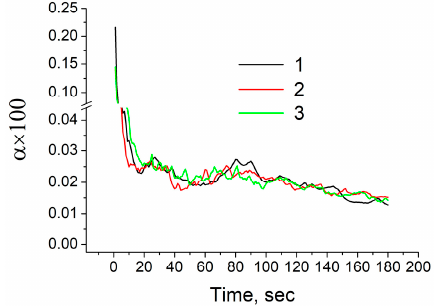
Figure 7. Time variation of dimensionless volume of mushy zone. 1: conventional casting; 2: UST HT casting; 3: UST FRHT casting.